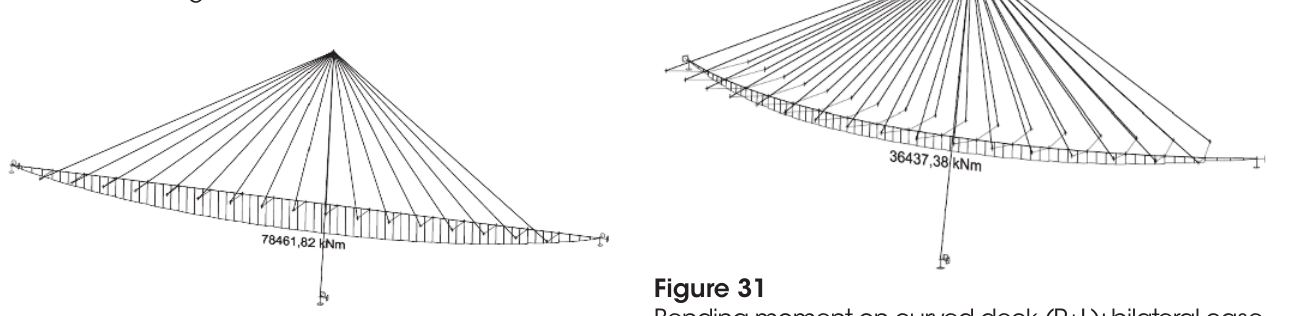
Figure 26 Model with straight deck: external case